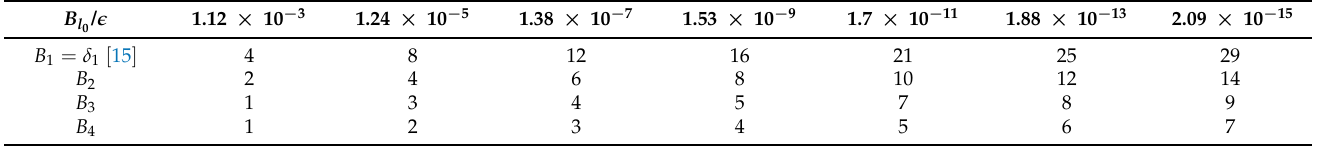
Table 4. Depth of a 4-point interpolating QSS curve